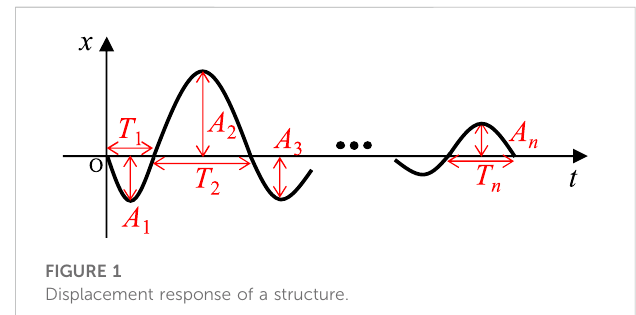
FIGURE 1 Displacement response of a